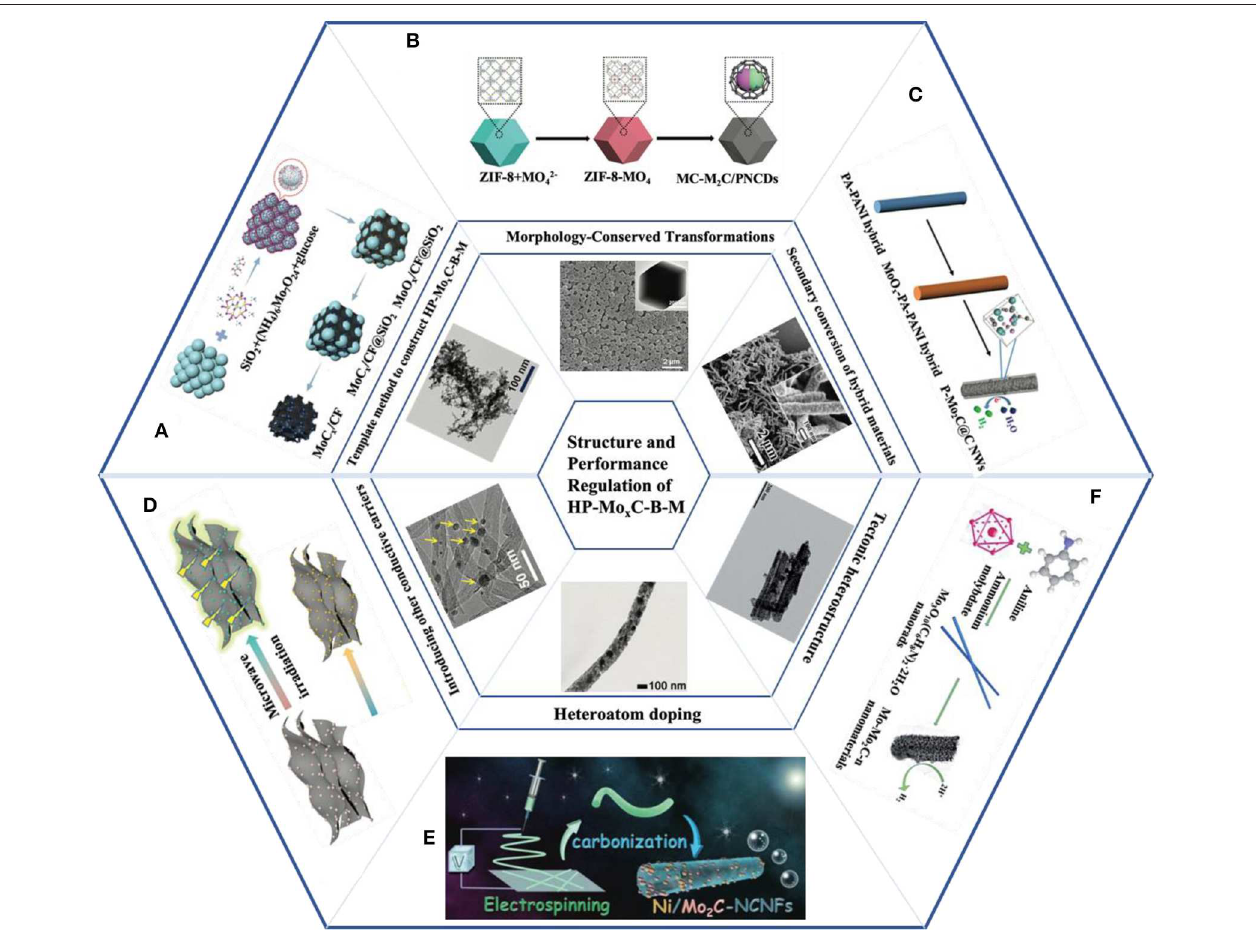
FIGURE 1 | Schematic illustration of synthesis and structures of various HP-Mo x C based catalysts: (A) Schematic synthesis route and TEM image of the uf-Mo 2 C/C. Reprinted with permission from Kou et al. (2018) with permission from WILEY-VCH. (B) Schematic synthesis route and SEM/TEM images of the MoC-Mo 2 C/PNCDs. Reprinted with permission from Lu et al. (2019) with permission from WILEY-VCH. (C) Schematic synthesis route and SEM image of the P-Mo 2 C@C NWs. Reprinted with permission from Shi et al. (2017) with permission from Royal Society of Chemistry. (D) Schematic synthesis route and HR-TEM image of the Mo 2 C/G. Reprinted with permission from Huang et al. (2019c) with permission from WILEY-VCH. (E) Schematic synthesis route and TEM image of the Ni/Mo 2 C-NCNFs. Reprinted with permission from Li et al. (2019b) with permission from WILEY-VCH. (F) Schematic synthesis route and TEM image of the Mo-Mo 2 C. Reprinted with permission from Dong et al. (2018) with permission from Royal Society of